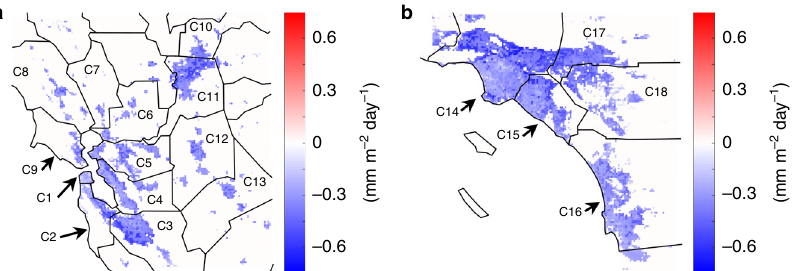
Fig. 6 Spatial distribution of cool-roof-induced changes in evaporative water demand. Simulated cool-roof-induced changes in evaporative water demand for NorCal ( a ) and SoCal ( b ). Values represent evapotranspiration averages over June – October of 2001 – 2015. The solid black lines illustrate the boundaries of the 18 urban counties that are captured in the model domains. Note that only changes that are over urban areas and statistically distinguishable from zero at 95% con fi dence interval are included